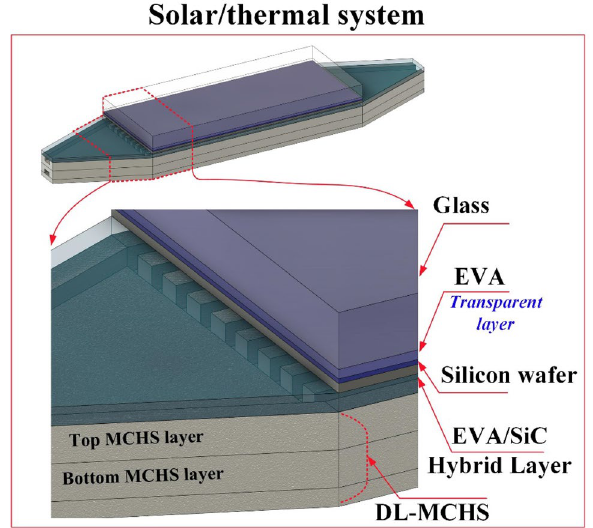
Figure 1. Schematic diagram for a three-dimensional concentrated photovoltaic module includes a double- layer microchannel heat sink device in the